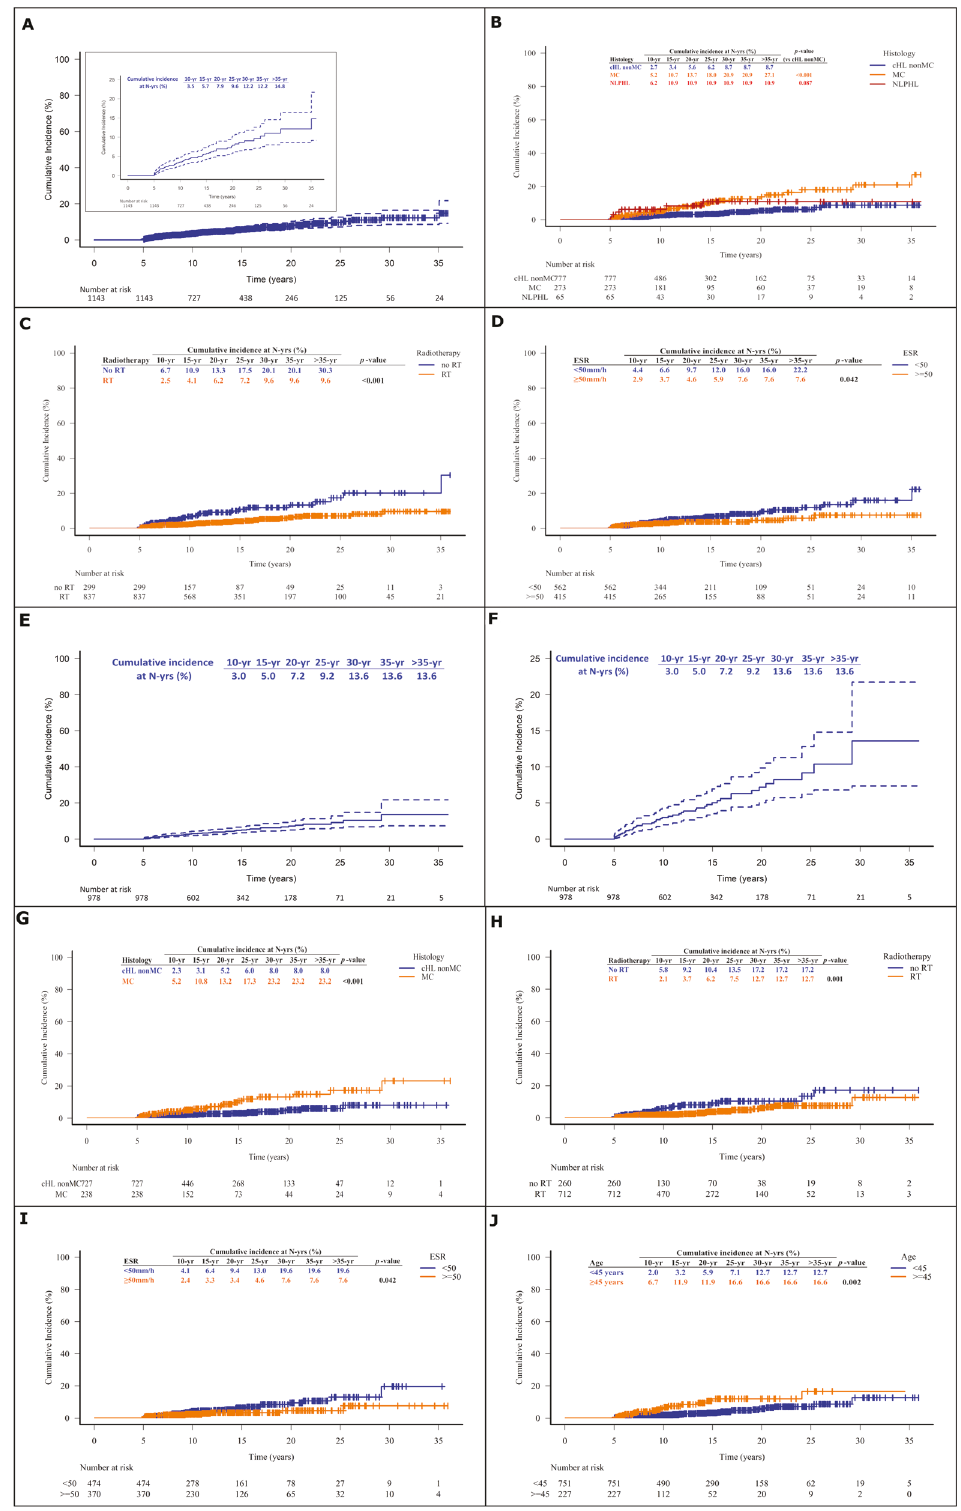
Fig. 1 Cumulative incidence of very late relapses and competing-risks-adjusted cumulative incidence at different time-points from diagnosis in the whole patient population and in individual patients ’ subgroups. Individual graphs refer to the whole patient population overall ( A ) and according to histologic subtype (cHL classical Hodgkin lymphoma, MC mixed cellularity, NLPHL nodular lymphocyte- predominant Hodgkin lymphoma) ( B ), radiotherapy (RT) administration ( C ) and erythrocyte sedimentation rate (ESR) ( D ). In addition, cumulative incidence of very late relapses and competing-risks-adjusted cumulative incidence at different time-points from diagnosis in patients with classical Hodgkin lymphoma treated with ABVD or equivalent regimens ( E , F ) and according to histologic subtype (cHL classical Hodgkin lymphoma, MC mixed cellularity) ( G ), radiotherapy (RT) administration ( H ), erythrocyte sedimentation rate (ESR) ( I ) and age ( J